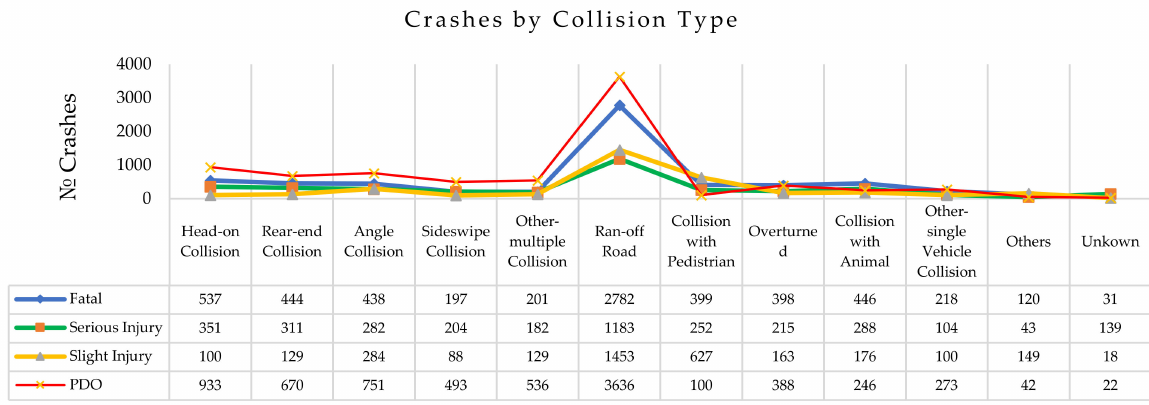
Figure 7. Crashes analyzed by collision types: